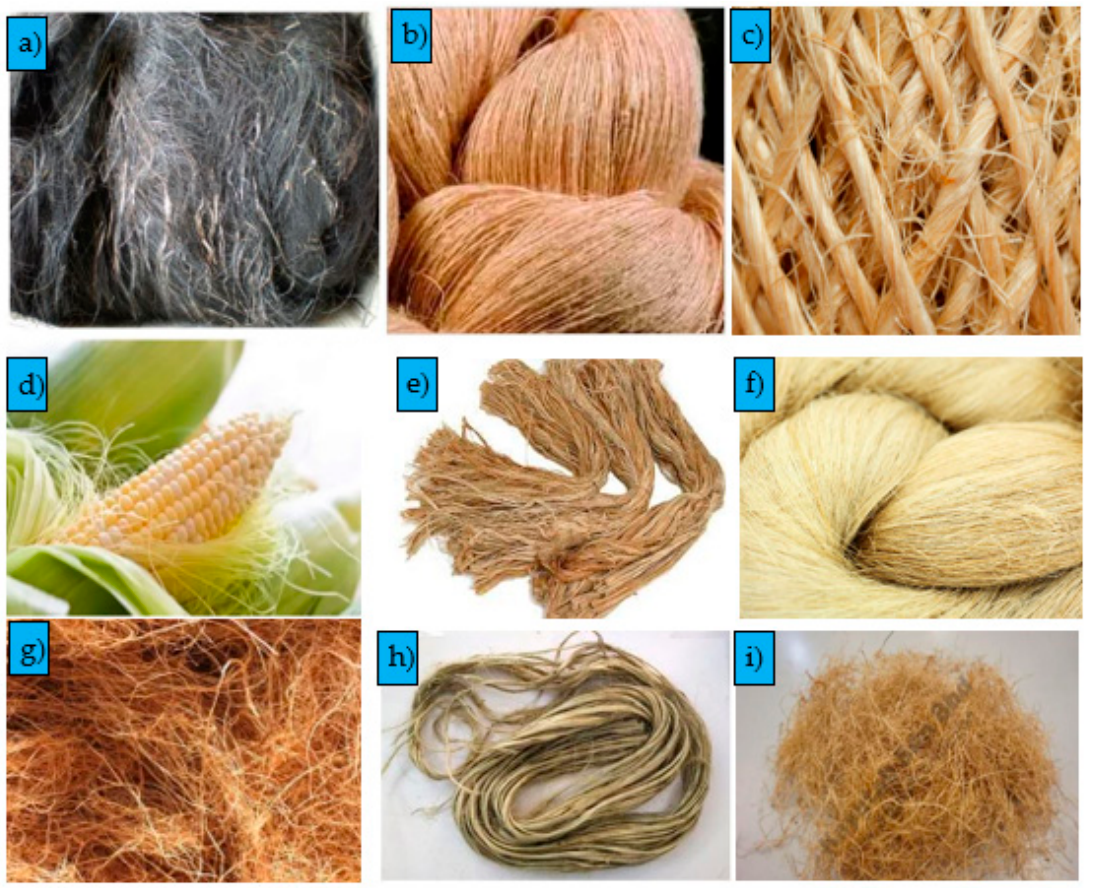
Figure 1. Diverse applications for hybrid natural/synthetic reinforced fiber polymer matrix. ( a ) Sugar palm fiber ( b ) Pineapple fiber ( c ) Hemp fiber ( d ) Corn fiber ( e ) Jute fiber ( f ) Flax fiber ( g ) Coir fiber ( h ) Kenaf Fiber ( i ) EFB fiber. Table 2 summarized the strength the range properties of different natural